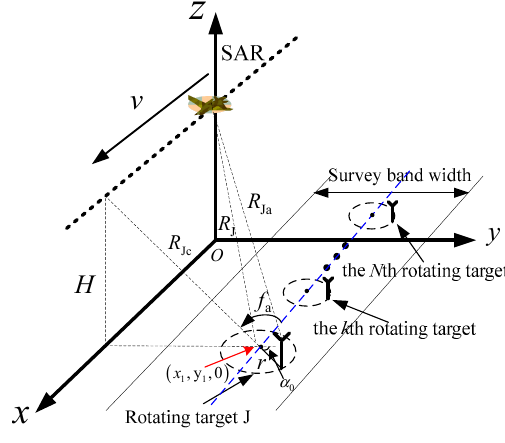
Figure 1. Radar-target geometry .